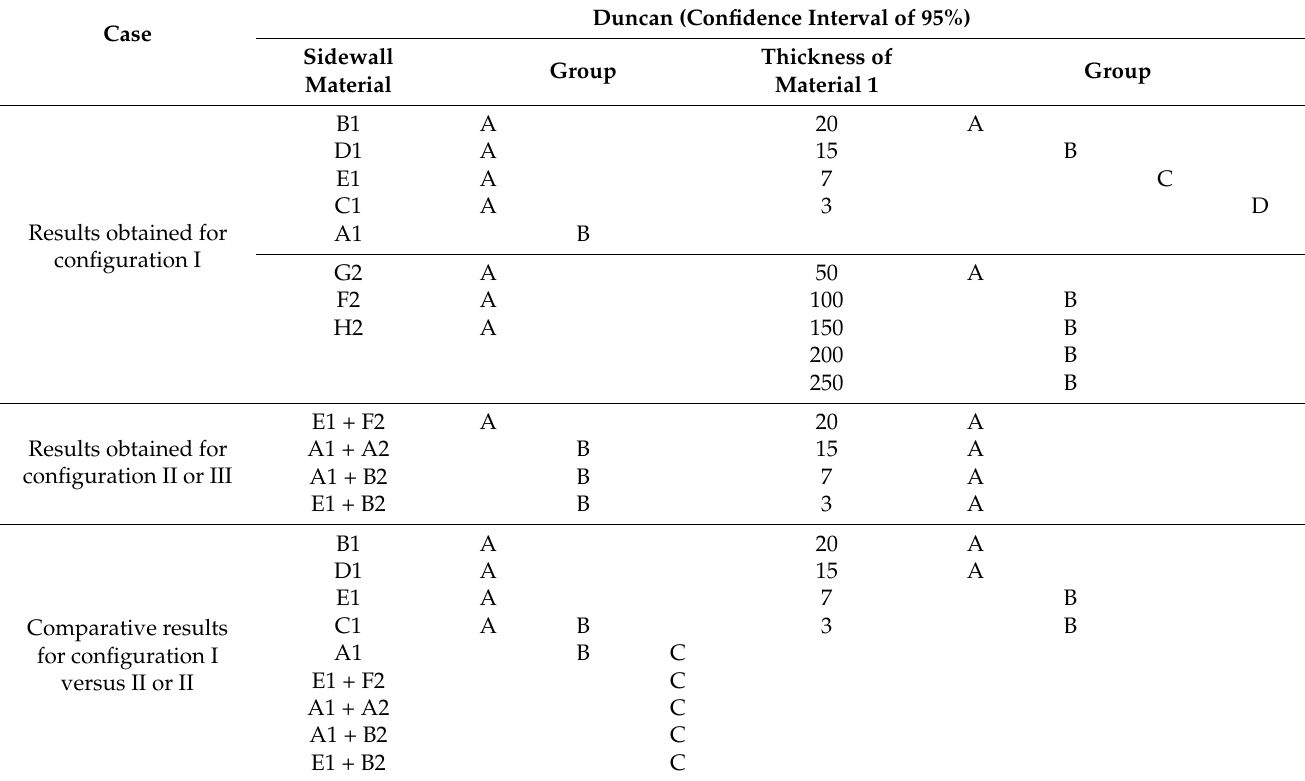
Table 9. Duncan’s test for heat loss from sidewalls of different configurations, materials, and mate- ria